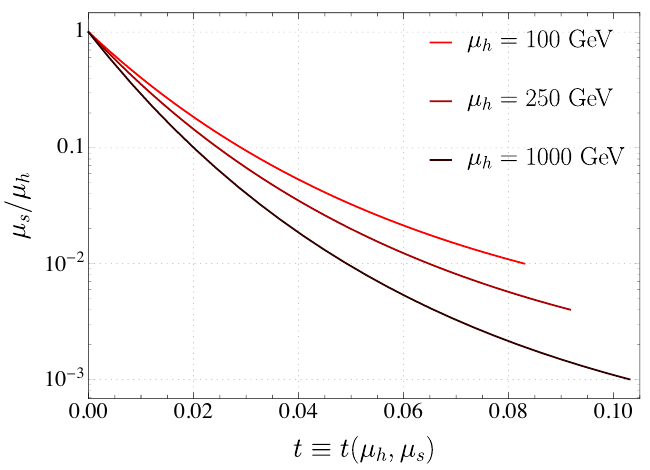
Figure 1 . The relation between shower time t , hard scale (cid:22) h and soft scale (cid:22) s . We stop the lines in the plot when (cid:22) s reaches 1